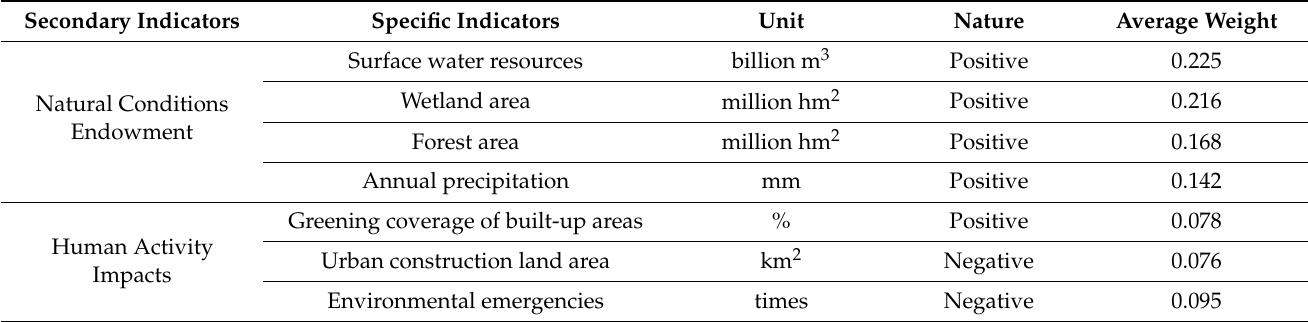
Table 1. Environmental Carrying Capacity (ECC) Indicator